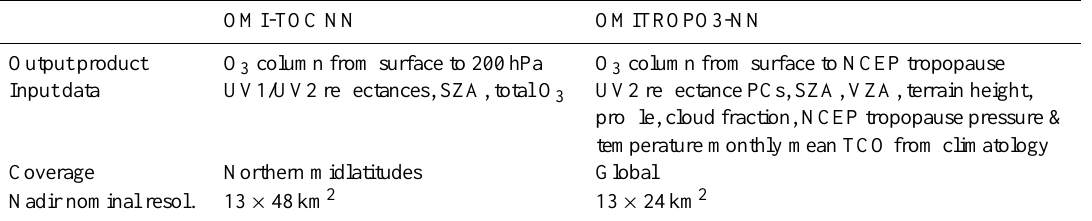
Table 1. Differences between the OMITROPO3-NN and the OMI-TOC NN algorithms. The OMI UV1 channel covers the range 270–310nm, the OMI UV2 channel covers the range 310–345nm. Acronyms: SZA (solar zenith angle), VZA (viewing zenith angle), PC (principal component), TCO (tropospheric column